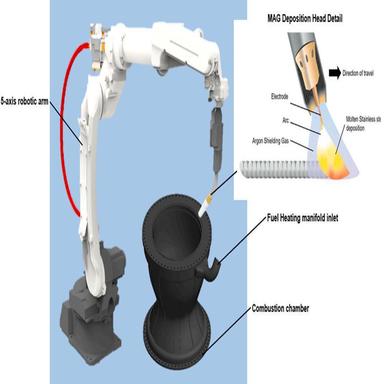
Schematic of the prototype 3D MAG deposition robot showing its position during the fabrication of a combustion chamber and the details of the deposition head.